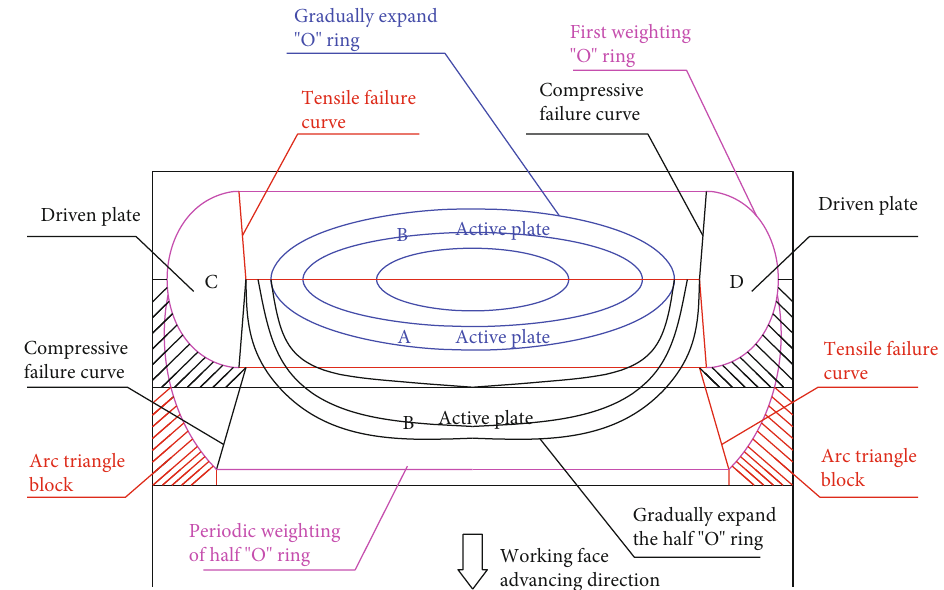
Figure 10: The spatial structure of periodic rupture of the main roof.